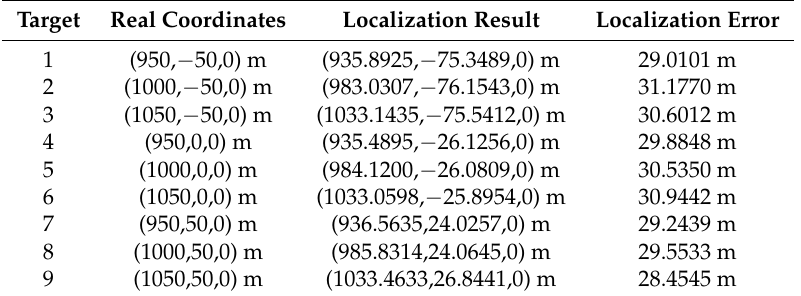
Table 7. Targets localization result proposed in [11,12] without height information.